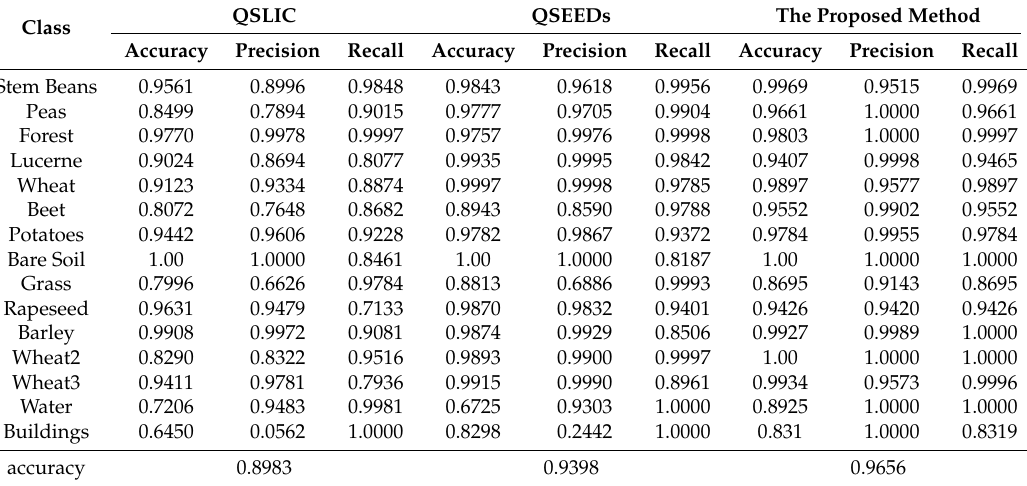
Figure 20. The visual classification results on San Francisco data set. ( a ) The classification map by QSLIC. ( b ) The classification map by QSEEDs. ( c ) The classification map by QPAN. Table 1. The accuracy, precision and recall for Flevoland data